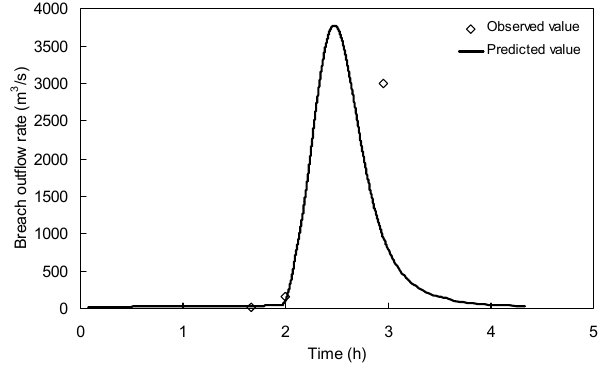
Table 4. Soil erodibility for the sensitivity